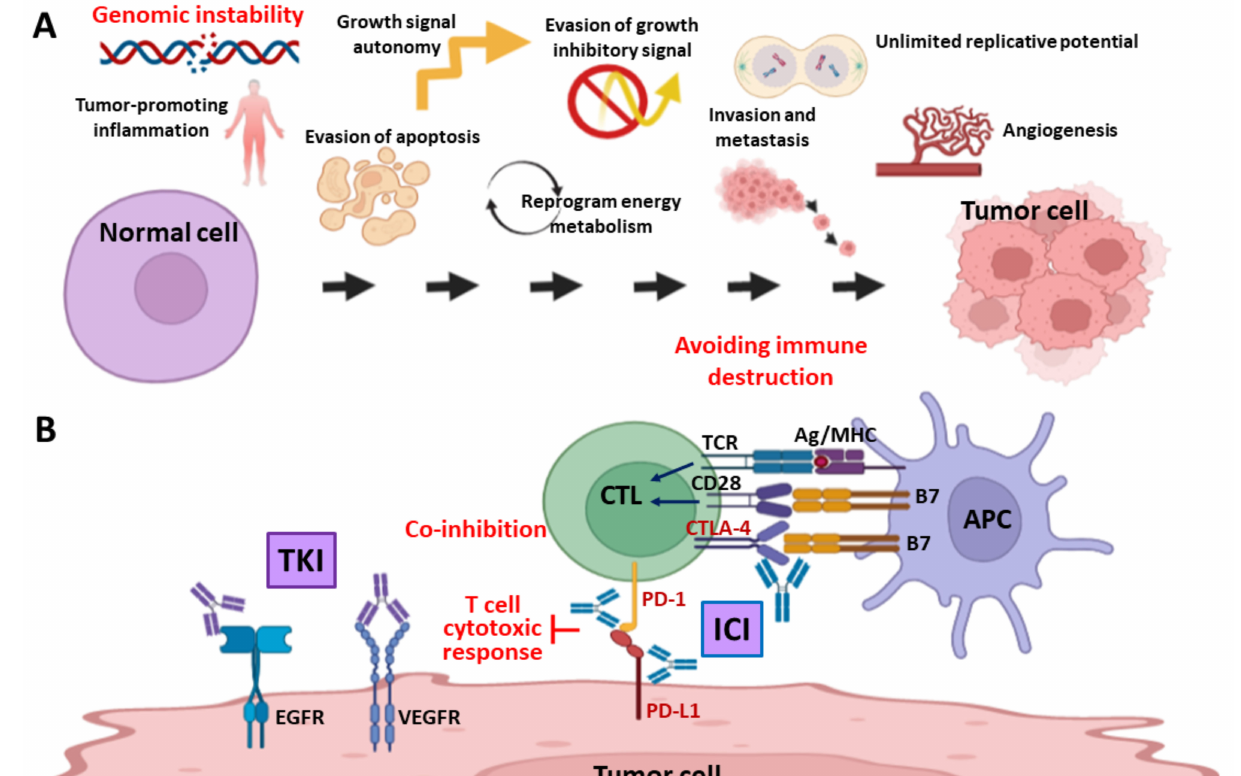
Figure 1. Cancer hallmarks, target therapy and immunotherapy. ( A ) Hallmarks and enabling charac- teristics of cancer. Hanahan and Weinberg propose six fundamental hallmarks (autonomous growth signal, evasion of growth inhibitory signal, evasion of apoptosis cell death, unlimited replicative potential, angiogenesis, and invasion and metastasis), two emerging hallmarks (reprogram energy metabolism and avoiding immune destruction), and two enabling characteristics (genomic instability and tumor-promoting inflammation) to distinguish cancer from normal cells. The genomic insta- bility and avoiding immune destruction (in red) are the principal foundations of synthetic lethality and immune checkpoint blockade-based cancer therapy. ( B ) Target therapy and immunotherapy. (Left part) The epidermal growth factor receptor (EGFR) and vascular endothelial growth factor receptor (VEGFR) are the major targets of tyrosine kinase inhibitors (TKI), such as Herceptin TM (trastuzumab) and Avastin TM (Bevacizumab). (Right part) The CTLA-4, PD-1, and PD-L1 are immune checkpoint molecules (in red) for cancer immunotherapy. The immune checkpoint inhibitors (ICI) include ipilimumab (anti-CTLA-4 antibody), nivolumab and pembrolizumab (anti-PD-1 antibody), and atezolizumab, avelumab and durvalumab (anti-PD-L1 antibody). Ag, antigen. APC, antigen presenting cells. CTL, cytotoxic T lymphocyte. MHC, major histocompatibility complex. TCR, T-cell receptor. Graph created with